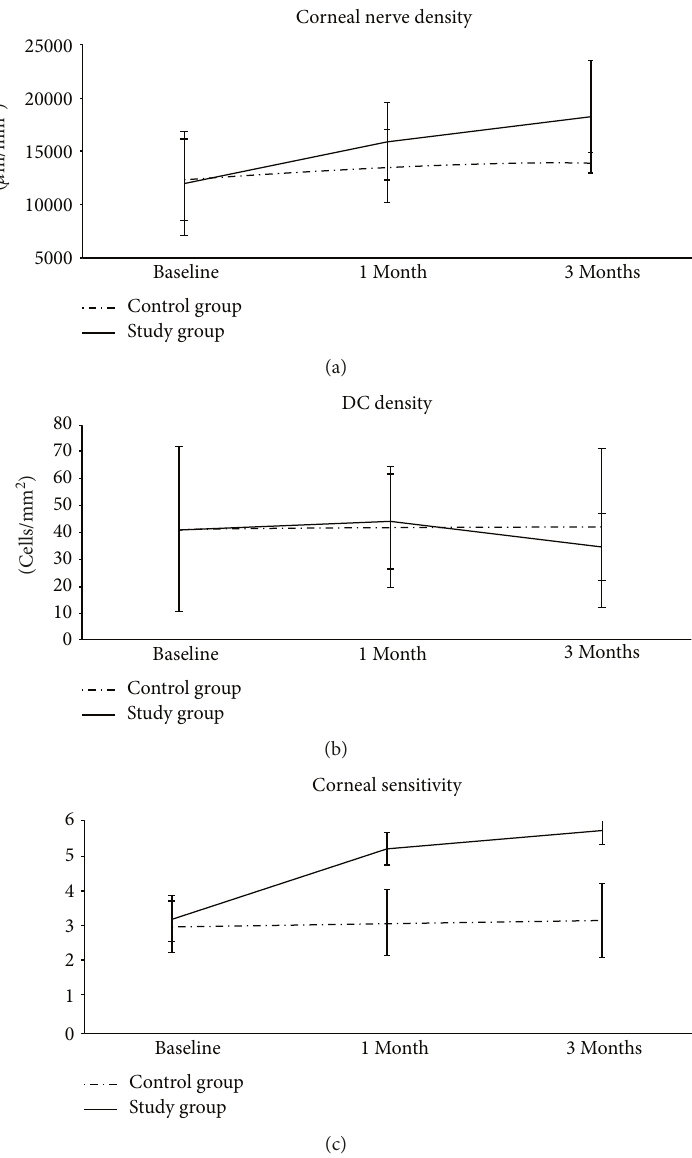
Figure 4: Changes in corneal nerve density (a), dendritiform cell density (b), and corneal sensitivity (c), in the study group (solid lines) and control group (dash lines). In the study group, there was a signi fi cant increase in the central corneal nerve density and a nonsigni fi cant change in the dendritiform cell density. In the control group, both corneal nerve and dendritiform cell density remained relatively